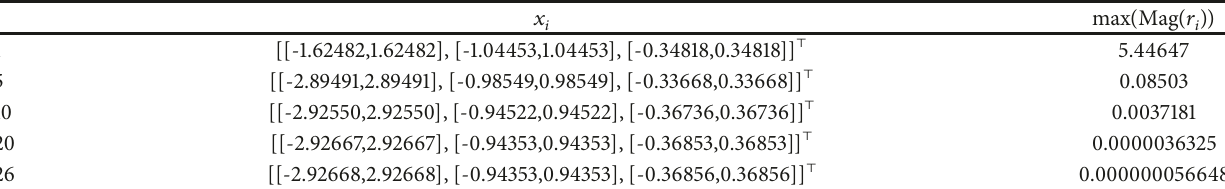
Table 2: Intermediate results of interval modified conjugate gradient method.